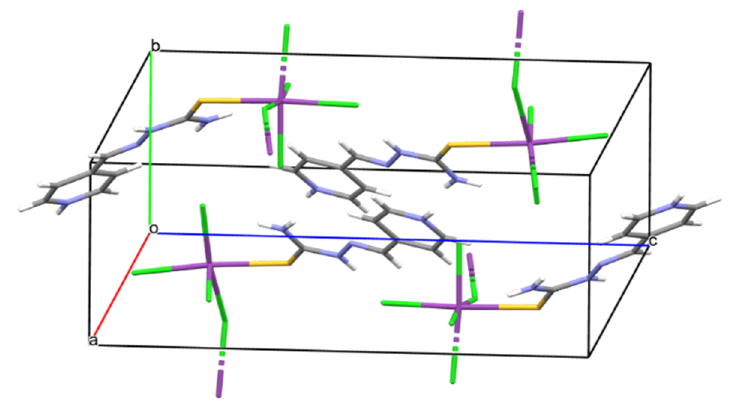
Figure 6. The structure of the [Bi(HQ)(Cl) 4 ] n compound unit cell.